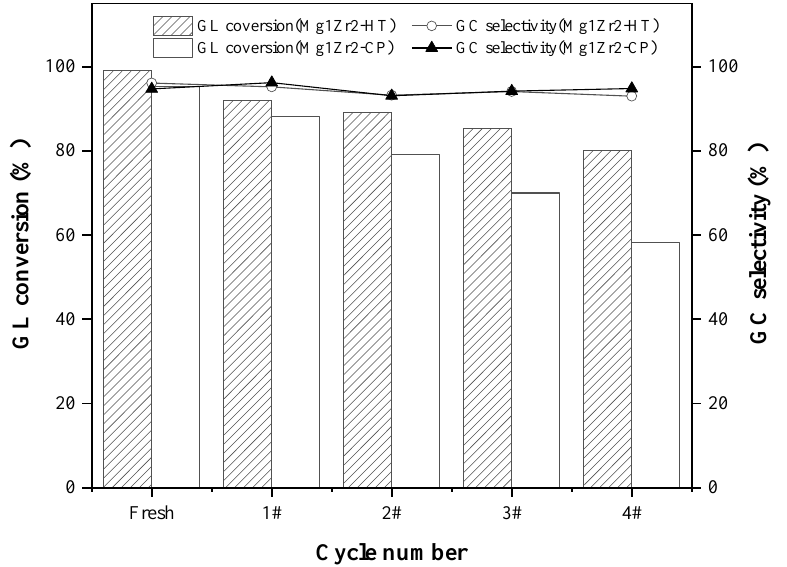
Figure 8. Reusability of Mg1Zr2-HT and Mg1Zr2-CP (Reaction condition: GL/DMC molar ratio = 1/5, catalyst loading = 3 wt%, 90 °C, 90 min).